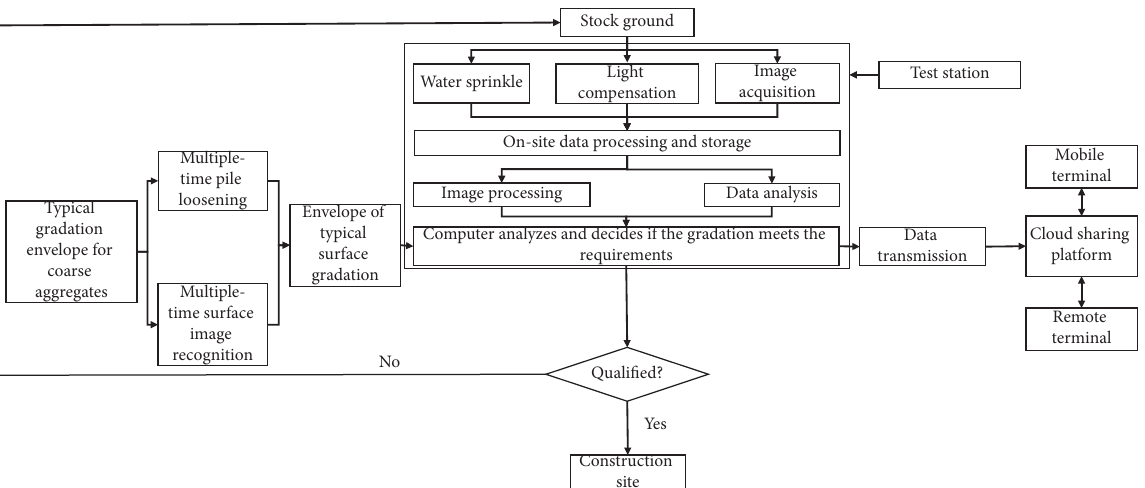
Figure 2: Flowchart of the gradation detection system for earth and stone materials.